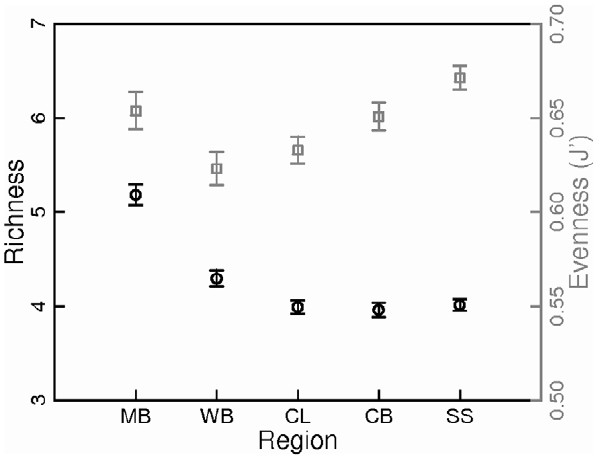
Figure 4. Regional variation in copepod species richness and evenness in the Gulf of Maine. Richness and evenness were based on standardized Continuous Plankton Recorder samples. Black circles - richness; gray squares - evenness. MB - Massachusetts Bay; WB - Wilkinson Basin; CL - Cashes Ledge; CB - Crowell Basin; SS - Scotian Shelf Inflow. Bars indicate standard error. N=477, 666, 1024, 851, and 1172, respectively.